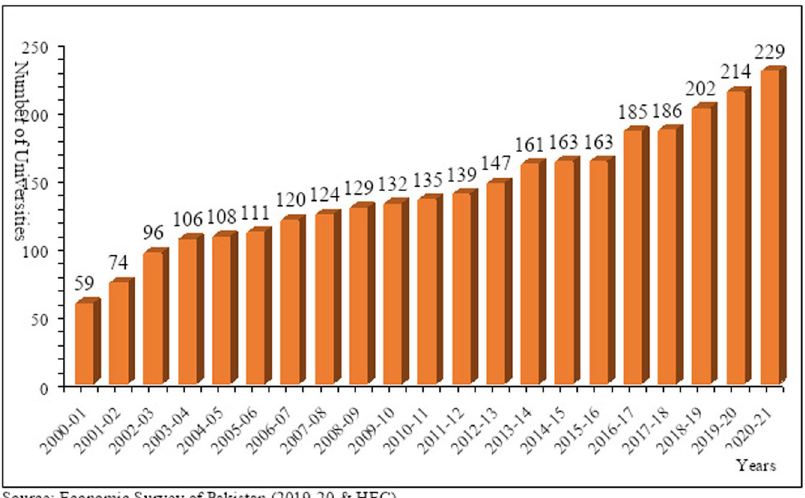
Fig. 1 Number of recognized universities in Pakistan. The total number of registered universities in the Higher Education Commission (HEC) of Pakistan till